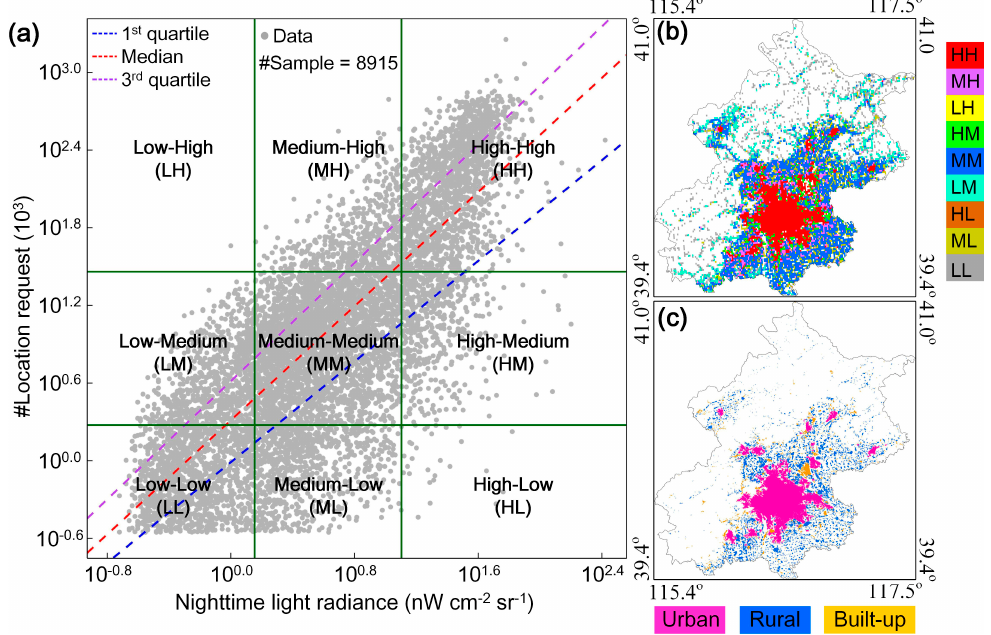
Figure 6. ( a ) Illustration of the pixel-level partition based on the bivariate plot of the nighttime light radiance and the number of location requests in Beijing. Green solid lines represent the first and the third quartiles; ( b ) Partitioning result according to ( a ); ( c ) Landsat data-derived artificial land distributions.